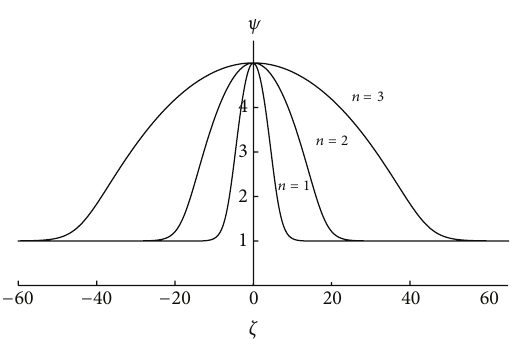
Figure 2: Rarefactive solitary wave for 𝑛 = 1, 2 , and 3 with Ψ = 5 . The length 𝜁 is scaled with the characteristic length 𝛿 𝑐 for 𝑛 = 1